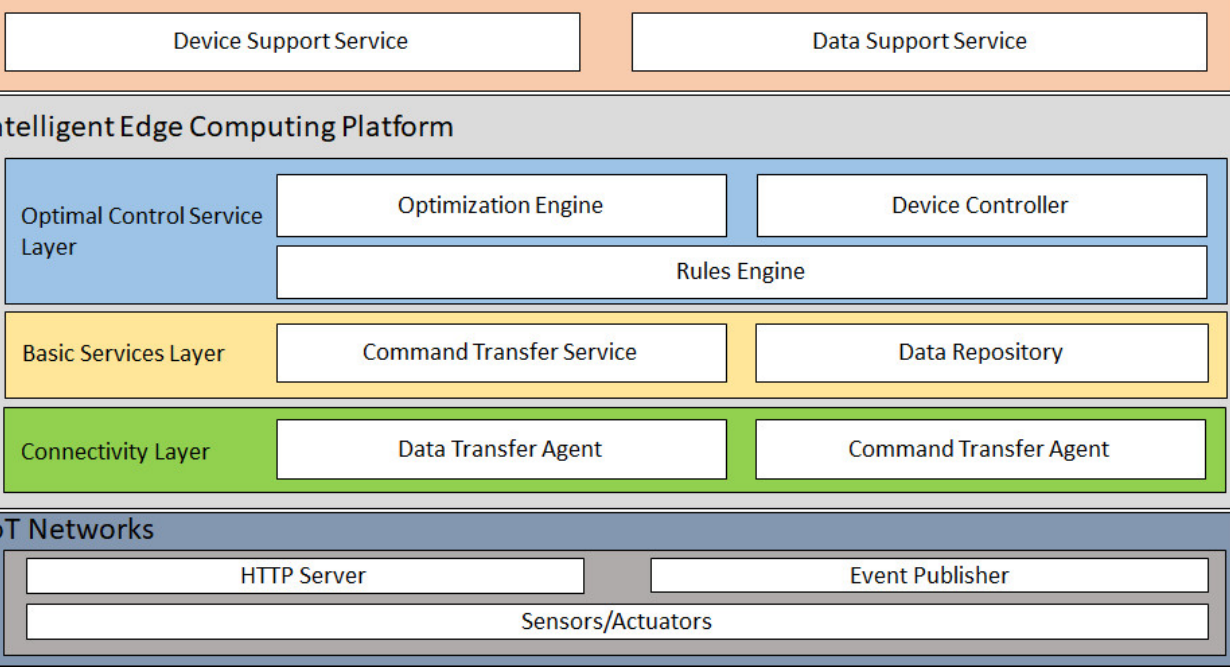
Figure 2. Proposed Distributed Intelligent Edge Computing Functionalities for Home Appliances